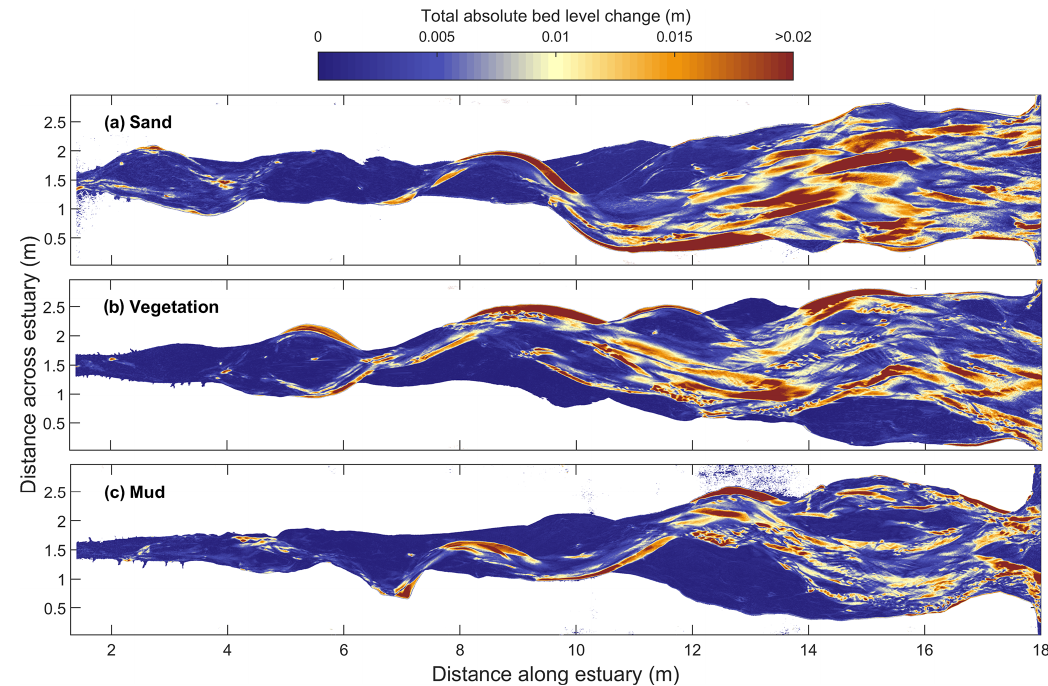
Figure 4. Morphodynamics characterised by cumulative absolute bed level change over the duration of the experiments with (a) sand only, (b) vegetation and (c) mud. To avoid overrepresentation by the early stages, only data of every 1000 cycles were used. The absolute bed level change is calculated from the moment that an area became part of the estuary for the first